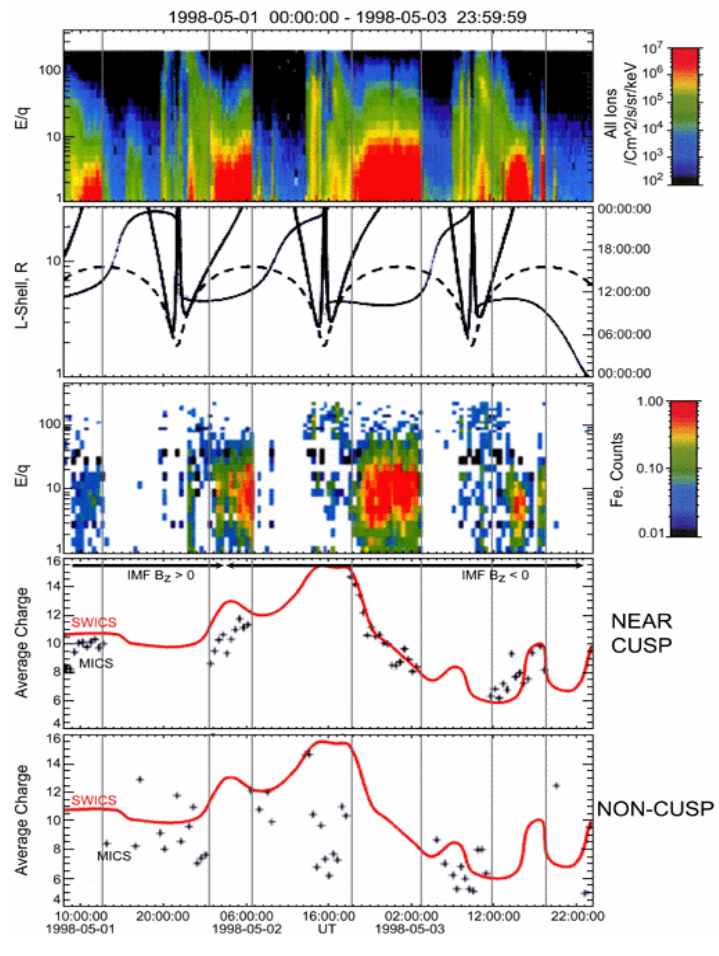
Fig. 1. Polar CAMMICE plasma data for 1–3 May 1998. (a) Total ion in- tensity, (b) orbital parameters for the Polar satellite showing the radial dis- tance (broken line) and L-shell (heavy solid line) with the scale on the left axis and Magnetic Local Time, MLT (lighter solid line) with scale on the right side axis, (c) the intensity of the Fe ions, (d) the average charge state of the Fe ions measured by the ACE SWICS instru- ment (red line) and measured by Polar in the region of the cusp/cleft (+), (e) same as above except the Polar mea- surements are in regions other than the cusp/cleft. This figure has been modi- fied from Fig. 1 of Perry et al.